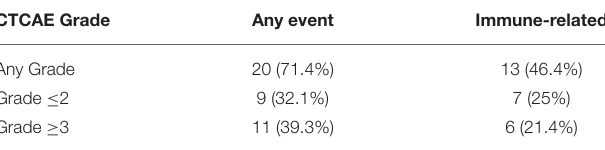
TABLE 2 | Adverse events.